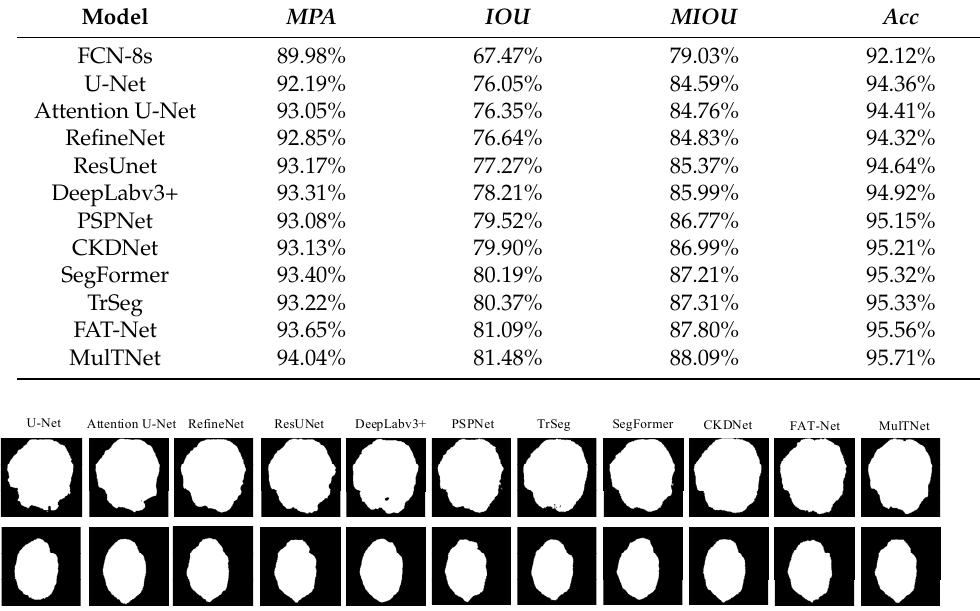
Table 4. Comparison of various segmentation networks for the public ISIC 2018 dataset.